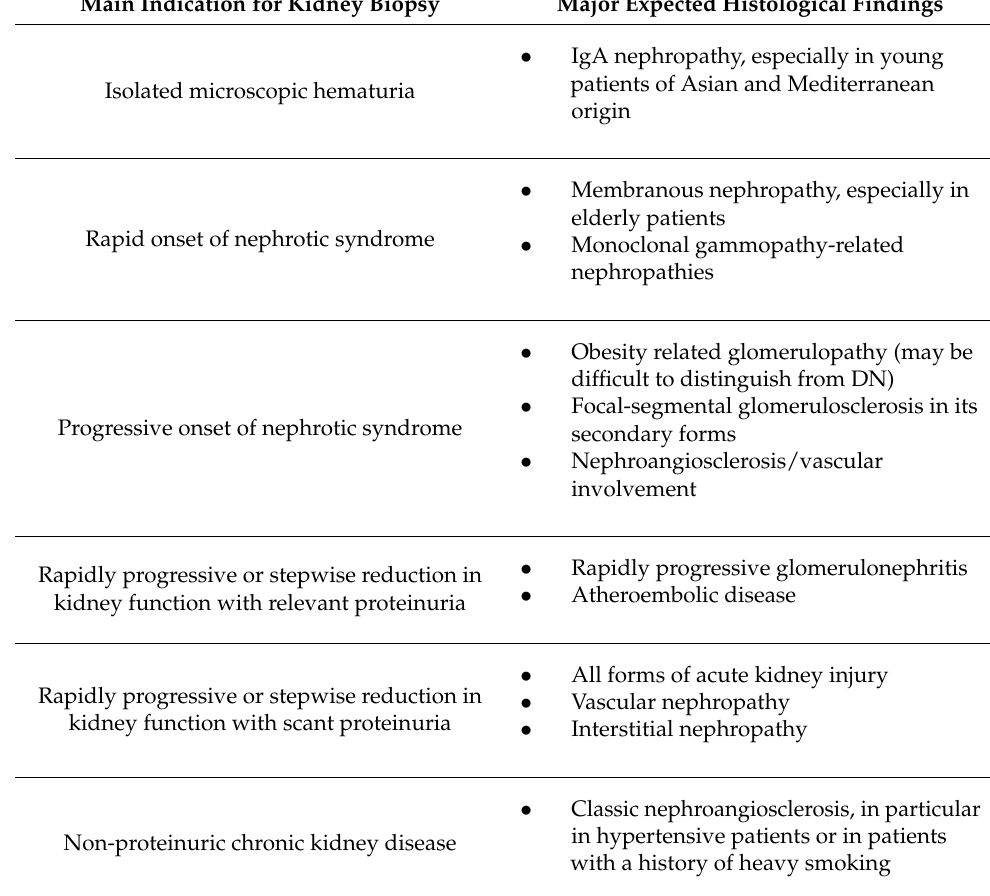
Table 2. Kidney biopsy indications in a diabetic patient and most likely histological findings other than diabetic